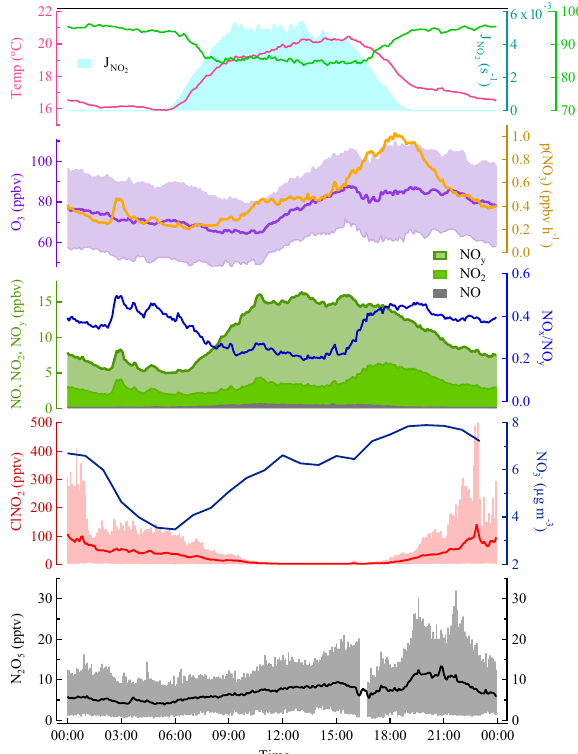
Figure 3. Diurnal variations of N 2 O 5 , ClNO 2 , NO x , NO y , O 3 , par- ticulate nitrate, nitrate radical production rate p (NO 3 ), and meteo- rological parameters during the study period at Mt. Tai. Shaded area in O 3 shows 2 σ variation, and vertical bars in N 2 O 5 and ClNO 2 represent 10–90th percentile